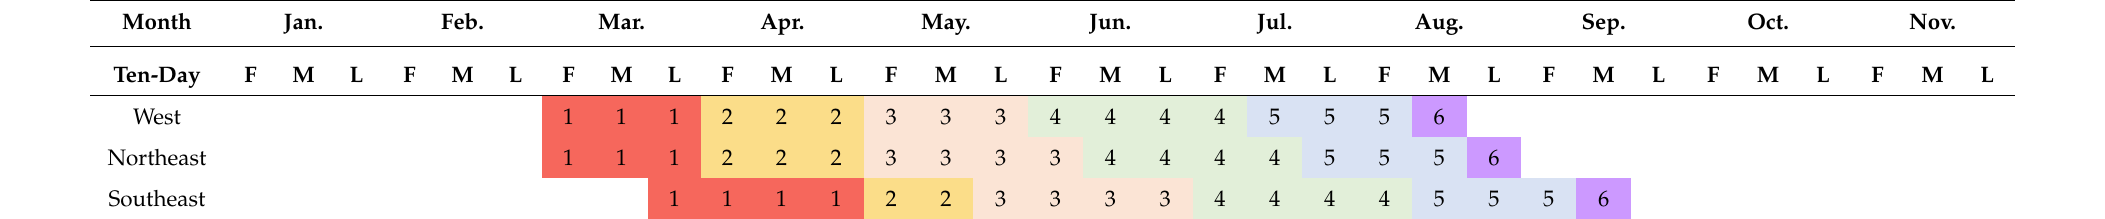
Table 1. Paddy rice planting calendar in Chongqing, the study area belongs to the western part of